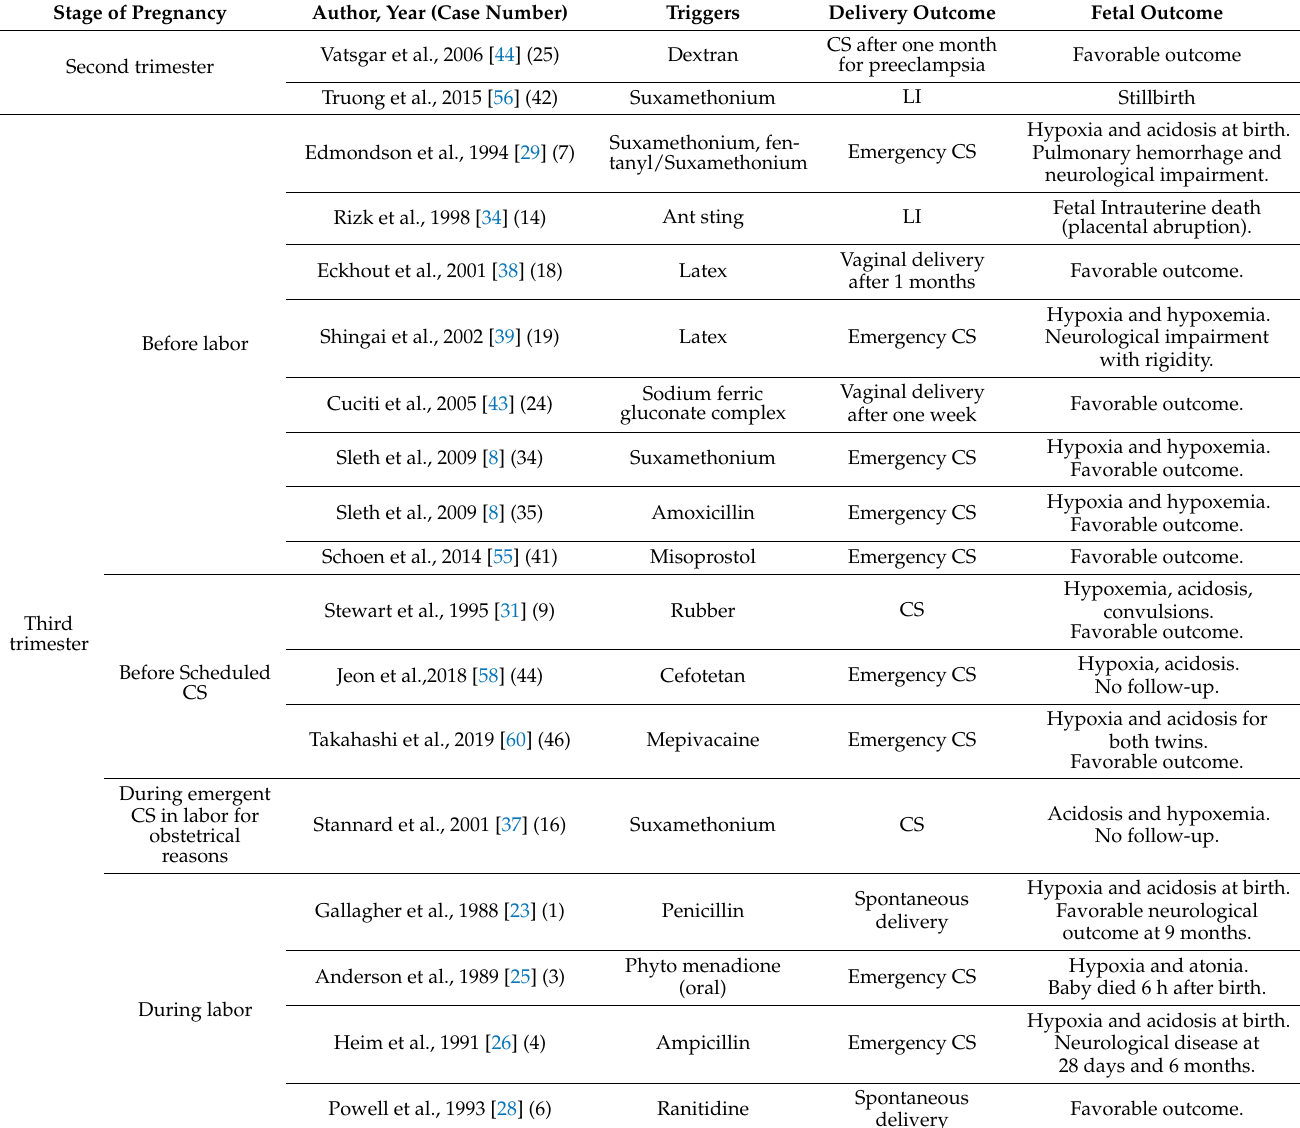
Table 3. Newborn outcomes for anaphylaxis in